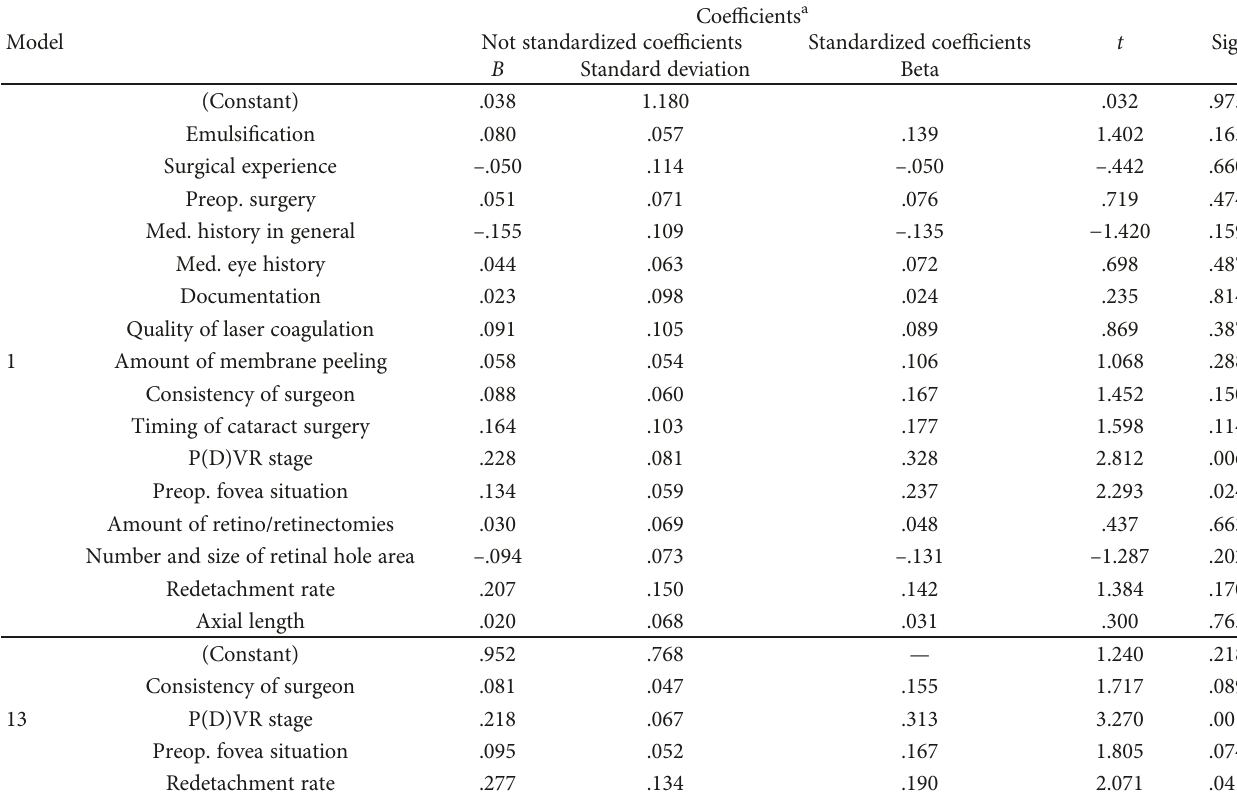
Table 7: Multiple regression to analyse essential factors for good postoperative vision in the prospective group.